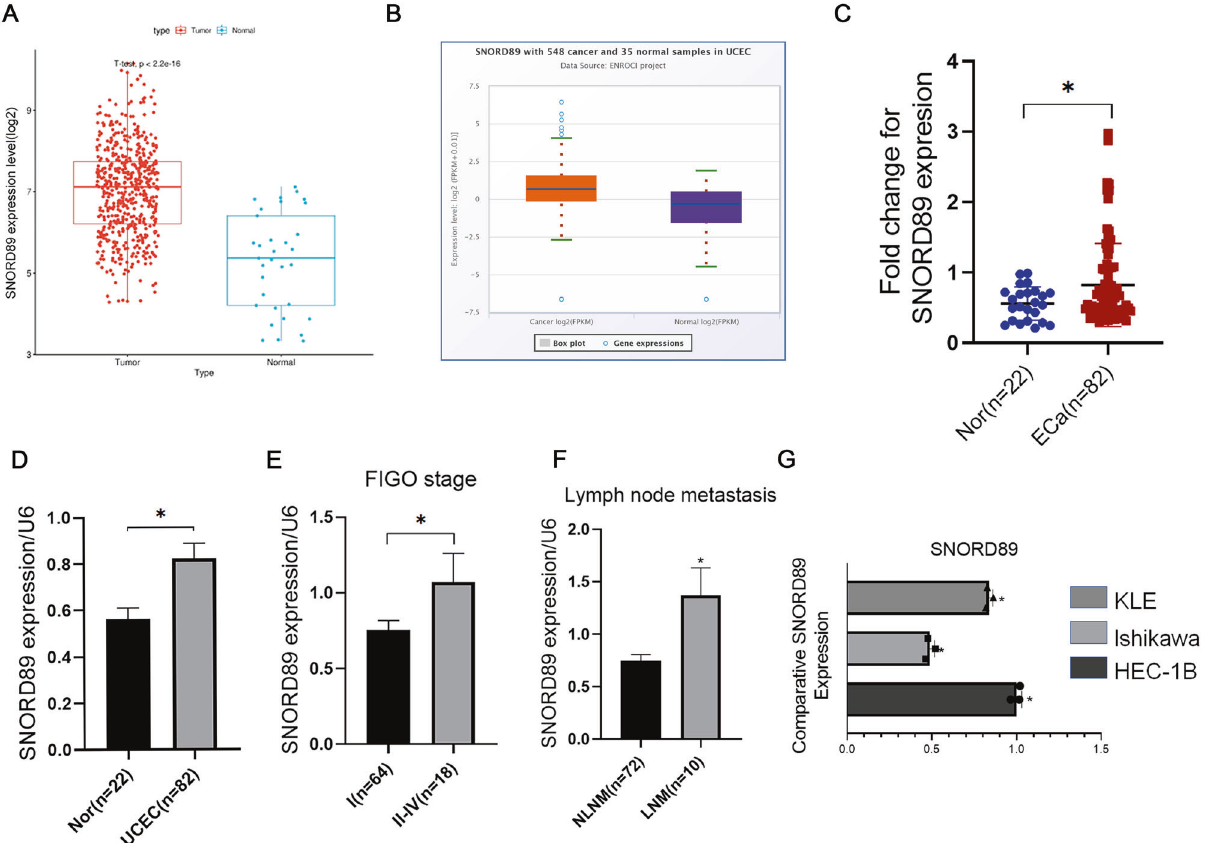
Fig. 1 Gene expression levels. A Data from TCGA database; B Data from starBase; C , D SNORD89 in tumoral ( n = 82) and nontumoral ( n = 22) endometrial tissue; E SNORD89 in stage I ( n = 64) and stage II-IV ( n = 18); F SNORD89 in tissues with lymph node metastasis, negative ( n = 72), positive ( n = 10). G SNORD89 in EC cell lines ( n = 3). Values are presented as the mean ± SD. * p ≤ 0.05; ** p ≤ 0.01; *** p ≤